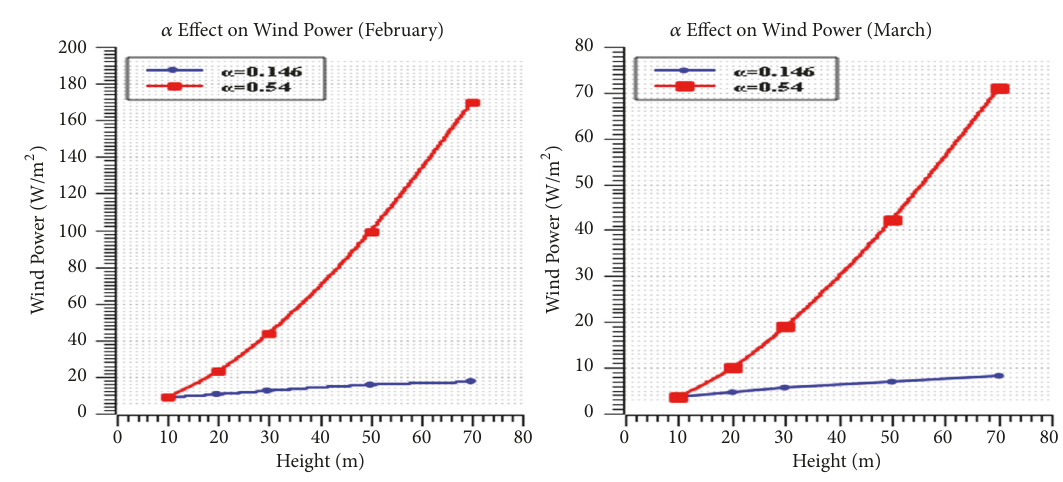
Figure 5: Effect of wind shear exponent on wind energy yield for Ikobe station.